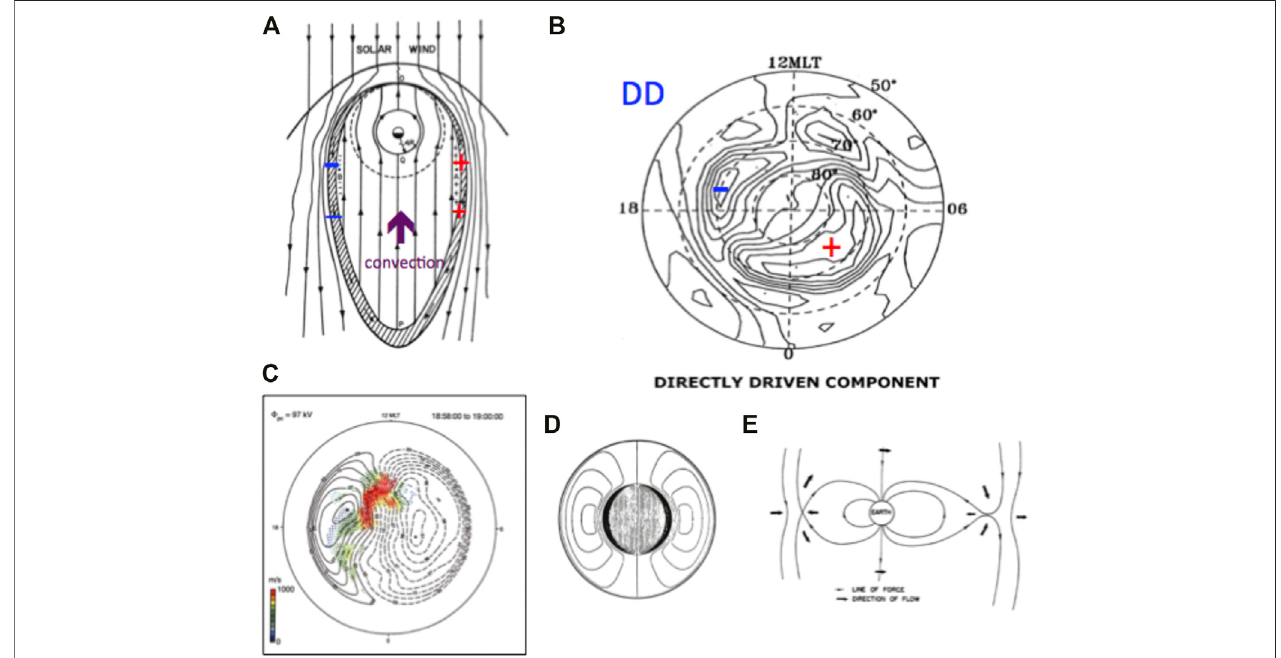
FIGURE 15 | (A) The convection pattern of plasmas in the equatorial plane, suggested by Axford and Hines (1961) on the basis of Chapman ’ s SD current. (B) The ionosphereconvectionpattern(thesameastheDDcurrent;thecurrentlineisthesameastheconvectionline)basedontheanalysisofthesixmeridianchainsofstation. (C) An example of the superDarn observation of the ionospheric convection. (D) Chapman ’ s SD current. (E) Dungey of convection model based on the SD current.